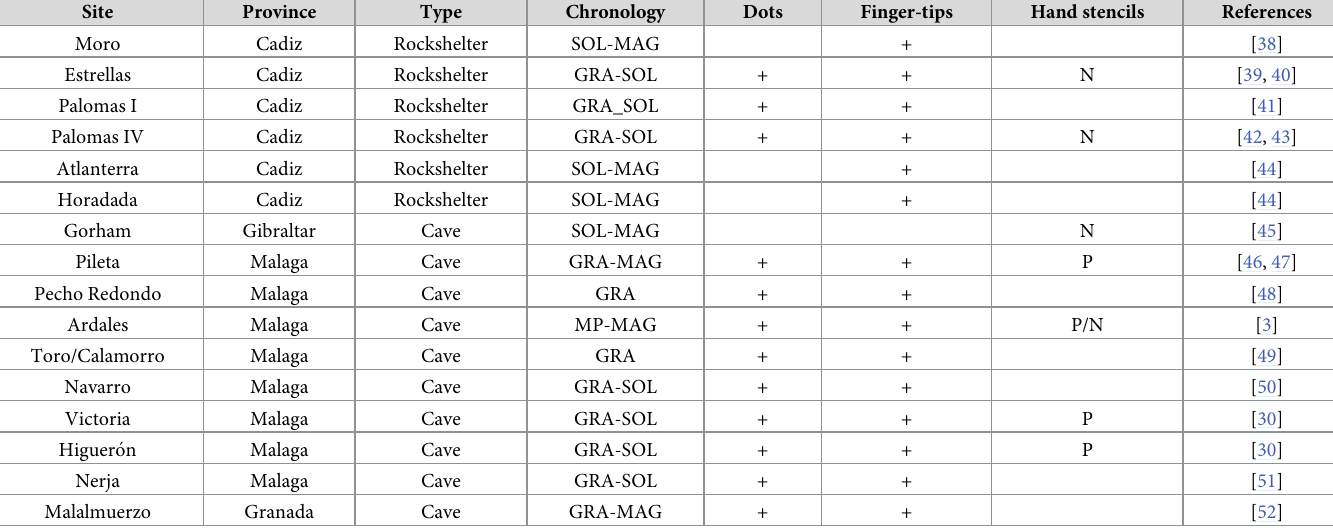
https://doi.org/10.1371/journal.pone.0266788.t008